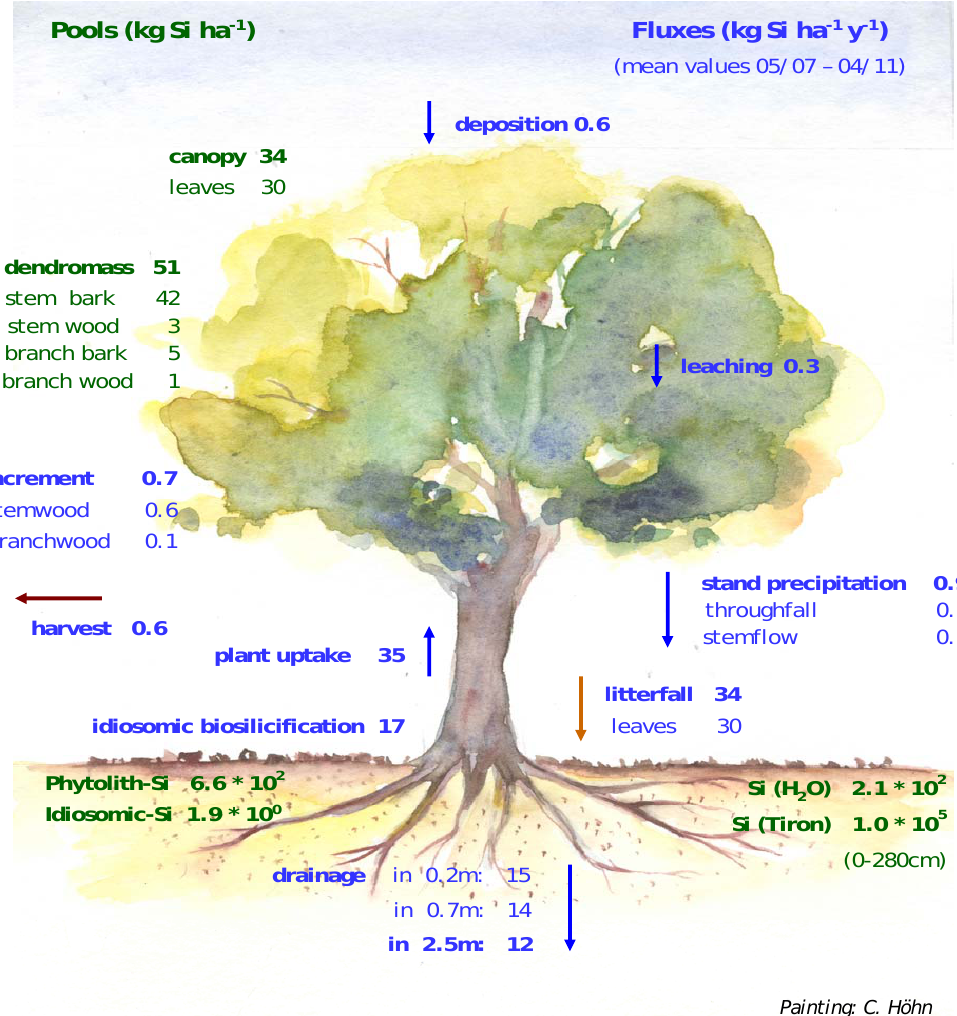
Fig. 4. Si pools and fluxes at Beerenbusch (mean values 05/2007–04/2011) (painting: Cornelia H¨ohn,